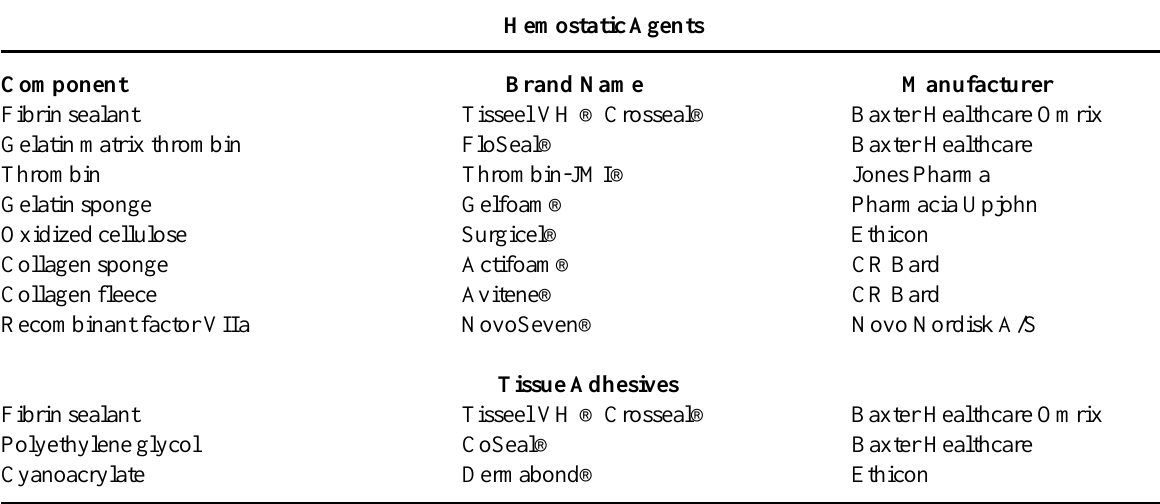
Table 1 – Hemostatic agents and tissue adhesive available in the United States.